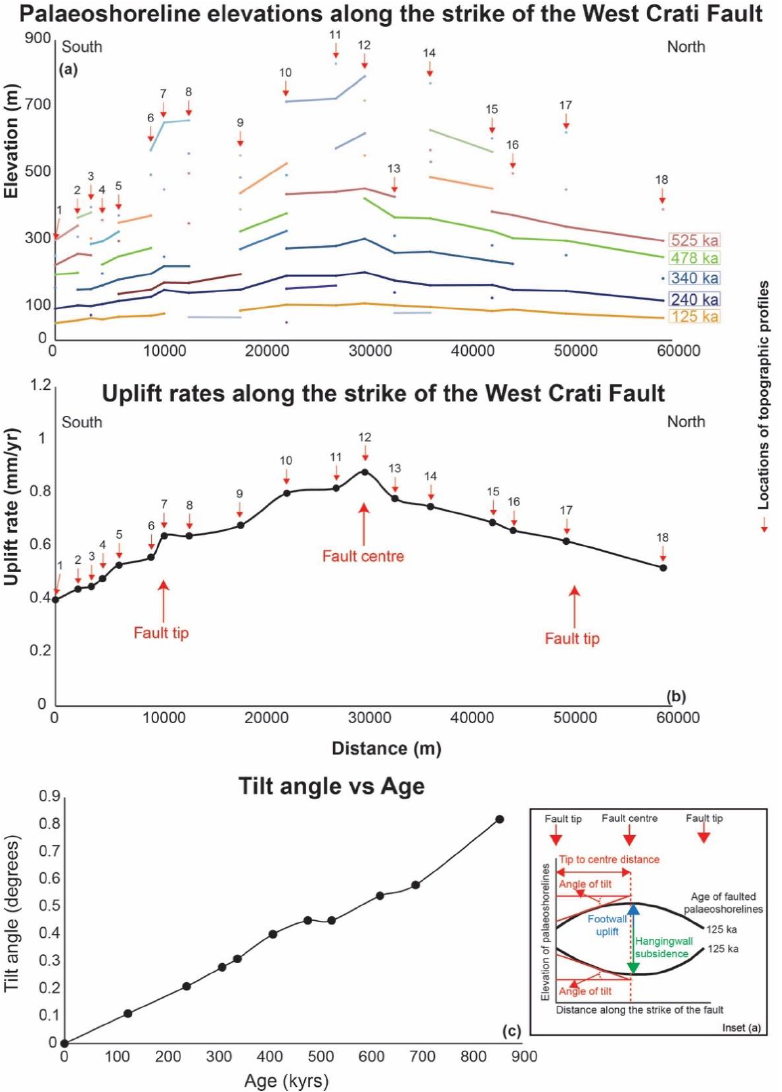
Figure 6. Crustal uplift ( a ) and uplift rates ( b ) over the Quaternary. Topographic profiles from Figure 2 are labelled. Palaeoshoreline elevations change along the strike of the West Crati Fault, suggesting Late Quaternary faulting activity ( a ). Spatially changing rates of uplift measured along the strike of the West Crati Fault outcropping on its uplifting footwall are also mapped ( b ). Values of tilting angles in degrees are calculated for each mapped marine terrace and are presented in ( c ), showing that older palaeoshorelines have higher tilt angles; this suggests that they have experienced a longer history of differential uplift and that differential uplift was ongoing progressively during the Late Quaternary. Note that values of tilt angle for each investigated marine terrace have been calculated as a tan −1 of a gradient m of a straight line (equation y = mx ), as proposed by previous studies [20,63,73].